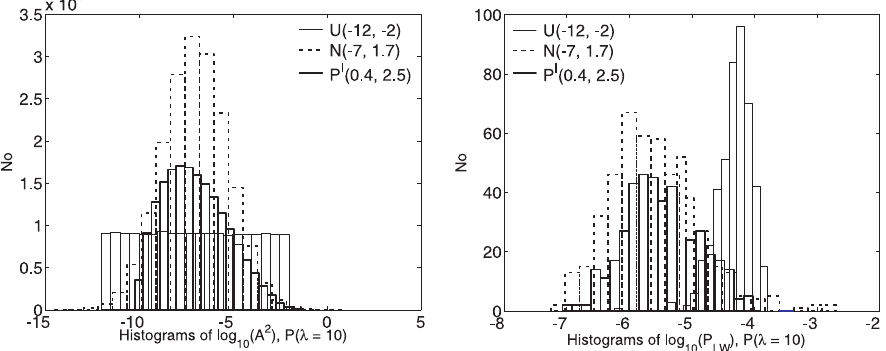
Fig. 1. An example of the wave packet simulation with log( A 2 1 : 7 2 ); P ( (cid:21) = 10). A i is the amplitude of wave packet, (cid:22) is the (cid:12)rst moment { mean value and (cid:27) is the second moment { standard deviation of normal probability distribution.